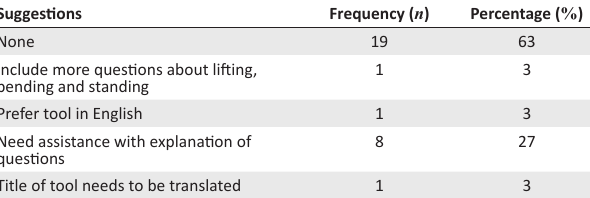
FIGURE 3: Time to complete the translated tool ( n = TABLE 3: Participants’ suggestions ( n = 30).